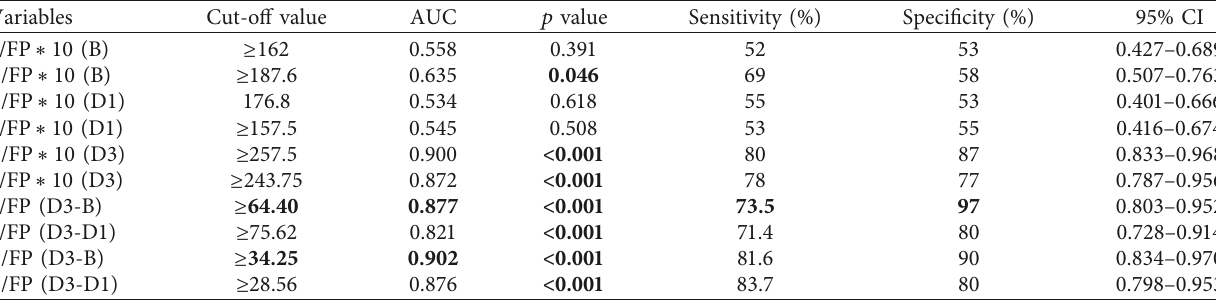
Table 3: Depiction of the predictive ability for survival for the various P/FP ∗ 10 and S/FP ∗ 10 ratios at different time intervals. Variables